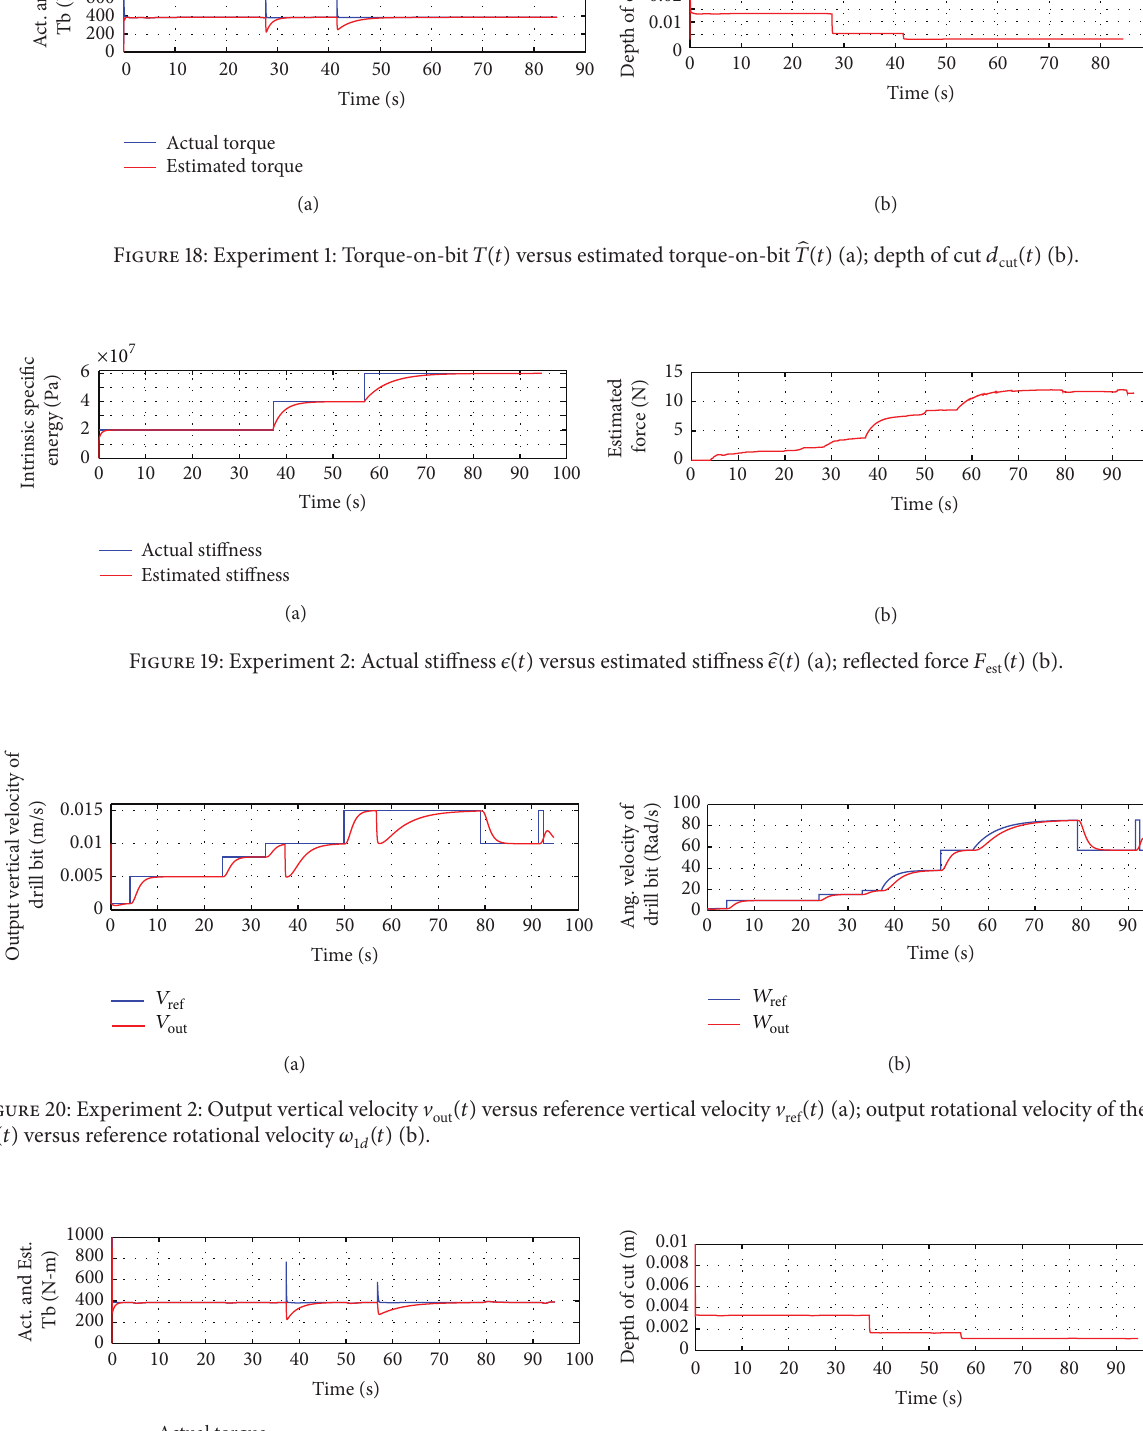
Figure 21: Experiment 2: Torque-on-bit 𝑇(𝑡) versus estimated torque-on-bit